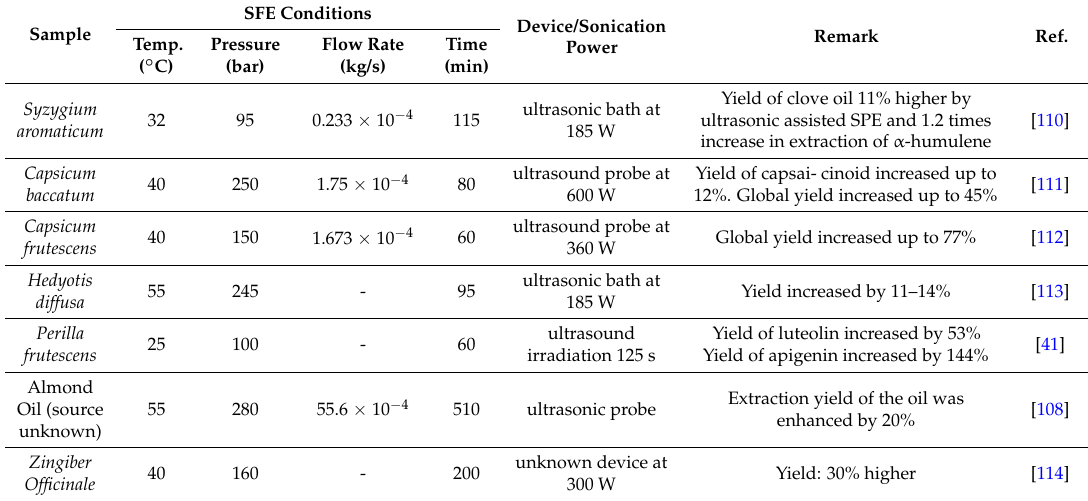
Table 5. Ultrasonic-Assisted supercritical fluid